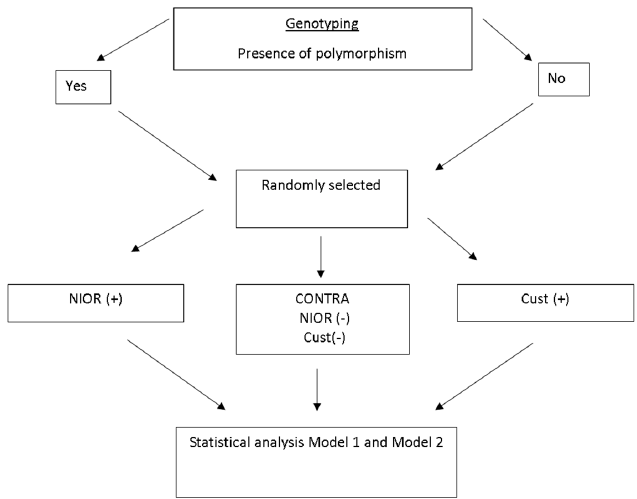
Figure 3. Baseline treatment characteristics. NIOR (+) represents individuals consuming a diet consistent with the results of genotyping; Cust (+), individuals consuming a diet comprising the typical dietary recommendations for NAFLD; NIOR ( − ) and Cust ( − ), individuals consuming a diet contrary to the genotyping results.